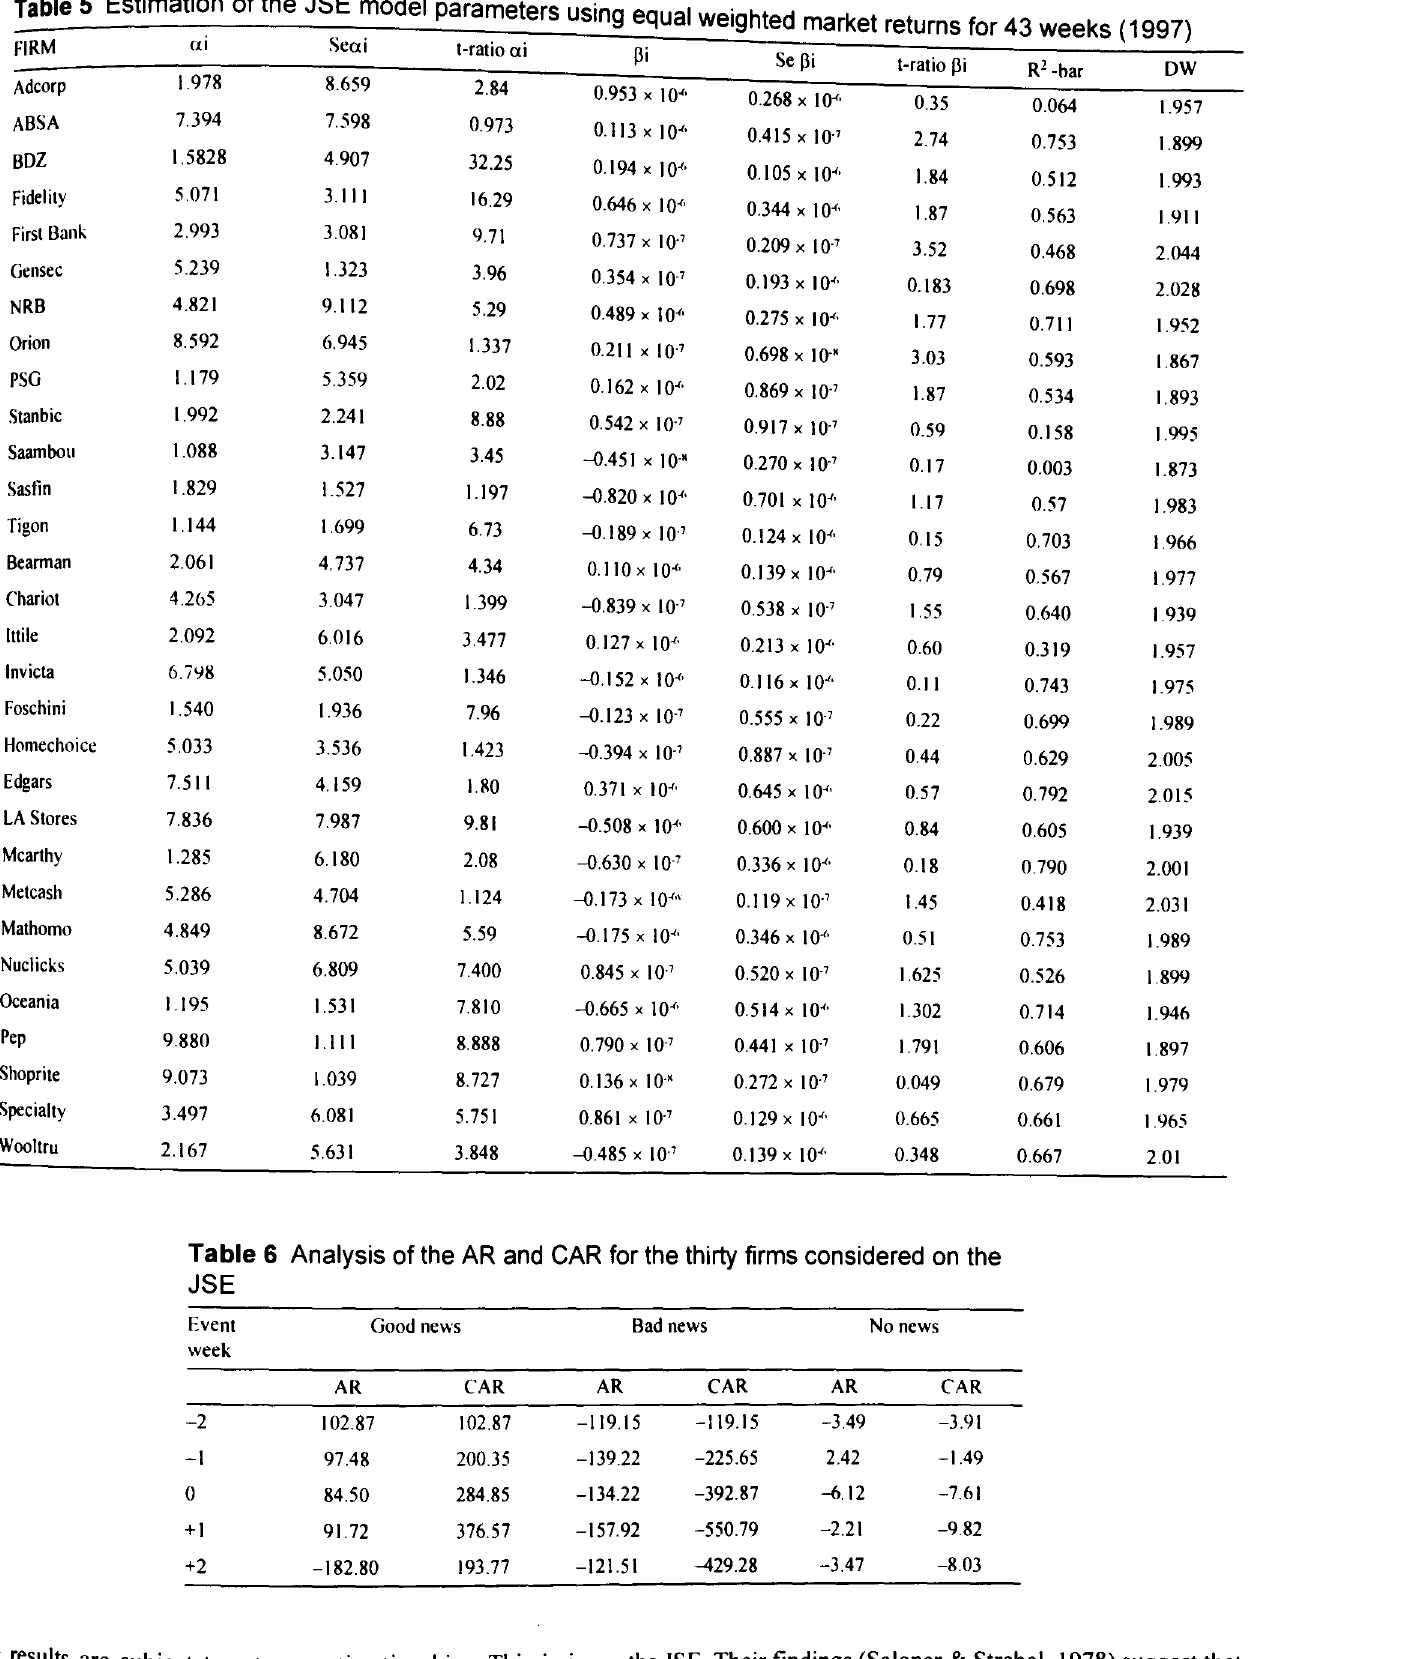
Table 5 Estimation of the JSE model parameters using equal weighted market returns for 43 weeks ( 1 997)